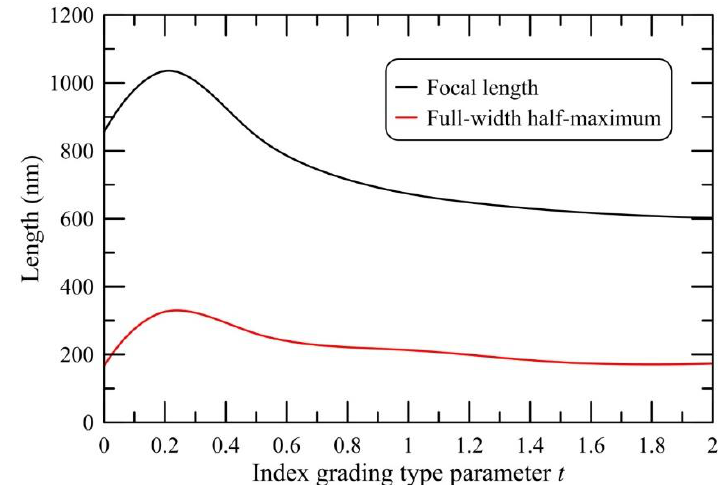
Figure 5. Focal length and full-width half-maximum as a function of the index grading type parameter for a cylindrical graded-index lens.